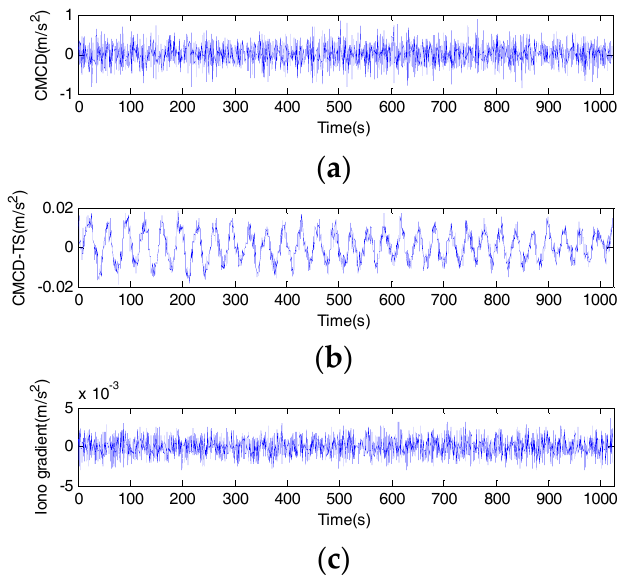
Figure 9. ( a ) Time series of the code-minus-carrier divergence (CMCD), ( b ) Time series of time-averaged CMCD, ( c ) Time series of ionospheric